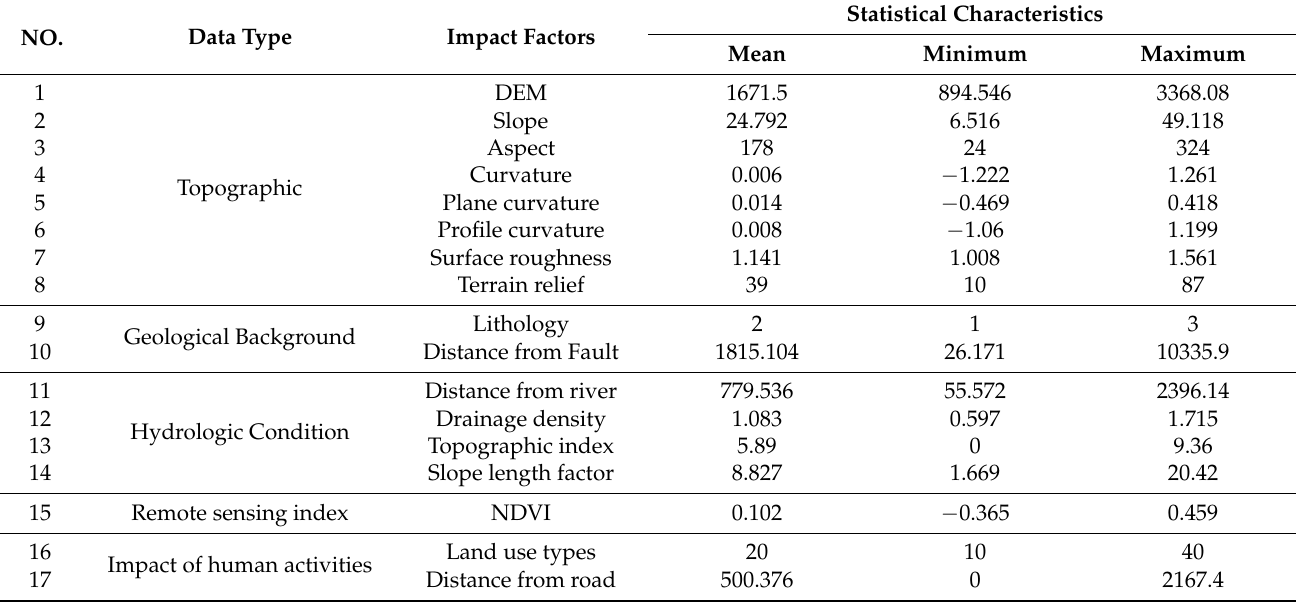
Table 2. List of potential active landslide influence